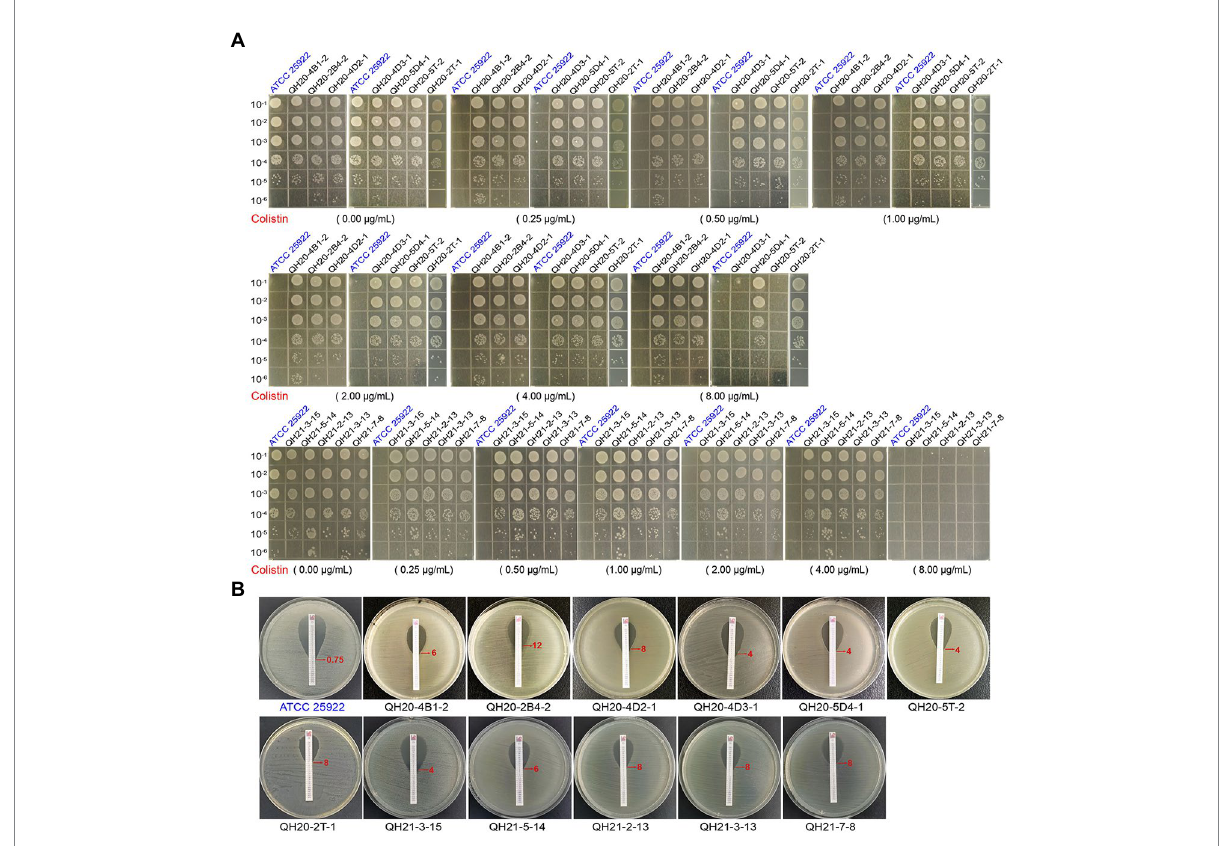
FIGURE 3 The insusceptibility of mcr -1-harboring Escherichia coli strains to colistin. (A) Bacterial viability of E. coli strains on LB plates containing different concentrations of colistin. The diluted suspension (10 μ l) was inoculated onto the prepared LB plates. Escherichia coli ATCC 25922 was used as a negative control. (B) E-test to compare the MIC of colistin in E. coli strains. Escherichia coli ATCC 25922 was used as a negative